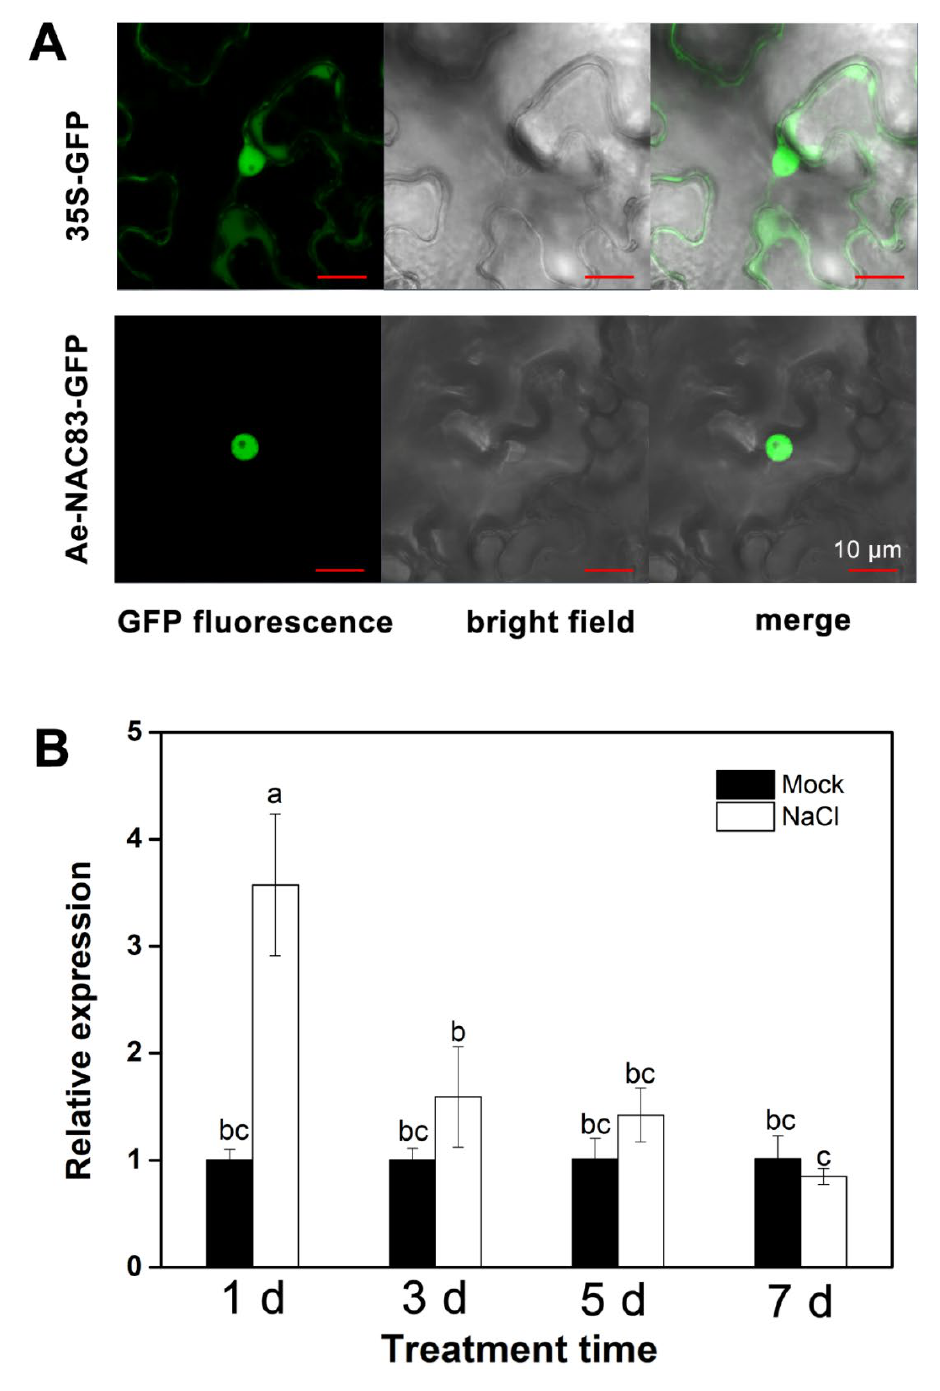
Figure 2. Subcellular localization and expression pattern of AeNAC83: ( A ) Subcellular localization of AeNAC83 in N. benthamiana . N. benthamiana cells were transformed with 35Sp:: AeNAC83 :GFP or pCAMBIA1300-GFP. After incubating for 48 h, the transformed cells were observed under a confocal microscope. The photographs were taken under detecting GFP fluorescence, bright field, and in combination (merge), respectively. Empty vector (pCAMBIA1300-GFP) was used as a control; ( B ) Expression of AeNAC83 in okra seedlings after 300 mM NaCl treatment by qRT-PCR. Total RNA for expression analysis was isolated from leaves of two-week-old seedlings after 300 mM NaCl treatment for 1, 3, 5, and 7 days. Data are presented as mean ± SD ( n = 3). Different letters denote significant differences at p < 0.05, using ANOVA and Duncan’s multiple